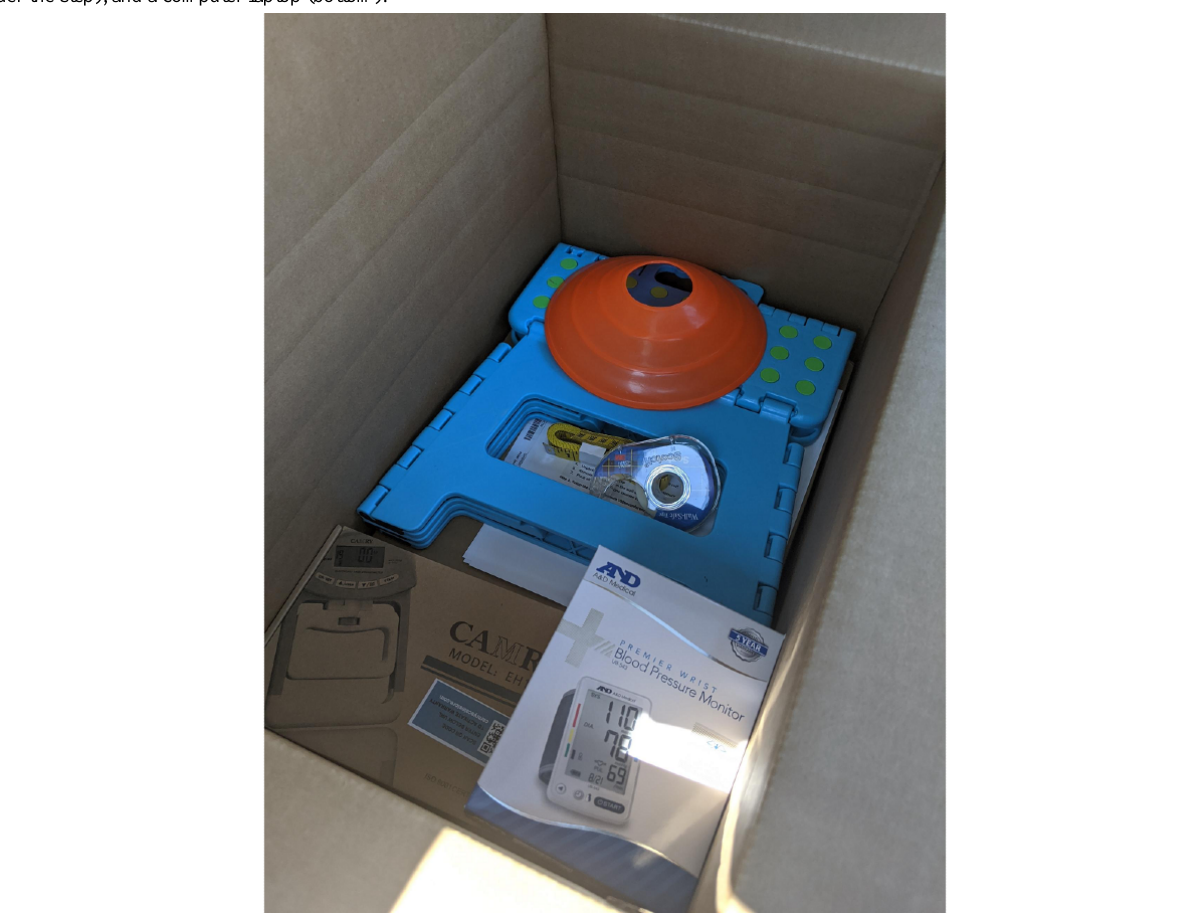
Figure 5. A teleassessment package prior to being shipped to a participant's home. The equipment includes an 8" step, a blood pressure cuff, a roll of wall-safe tape, a 3-meter measuring tape, a hand dynamometer, a mini disc cone, a large print paper with ruler metrics, a sheet with participant instructions (under the step), and a computer laptop